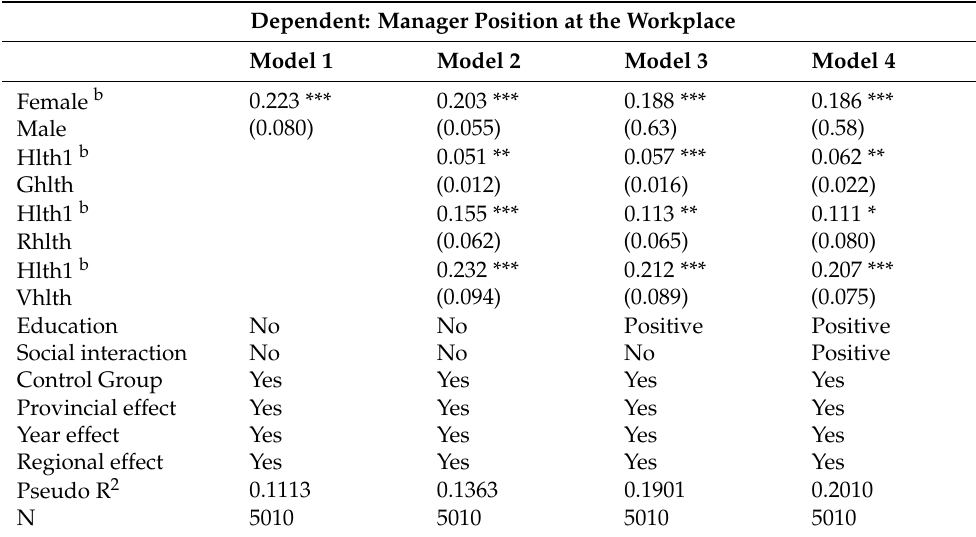
Table 4. Logit regression on manager position at workplace, CGSS 2013 and 2015. Dependent: Manager Position at the